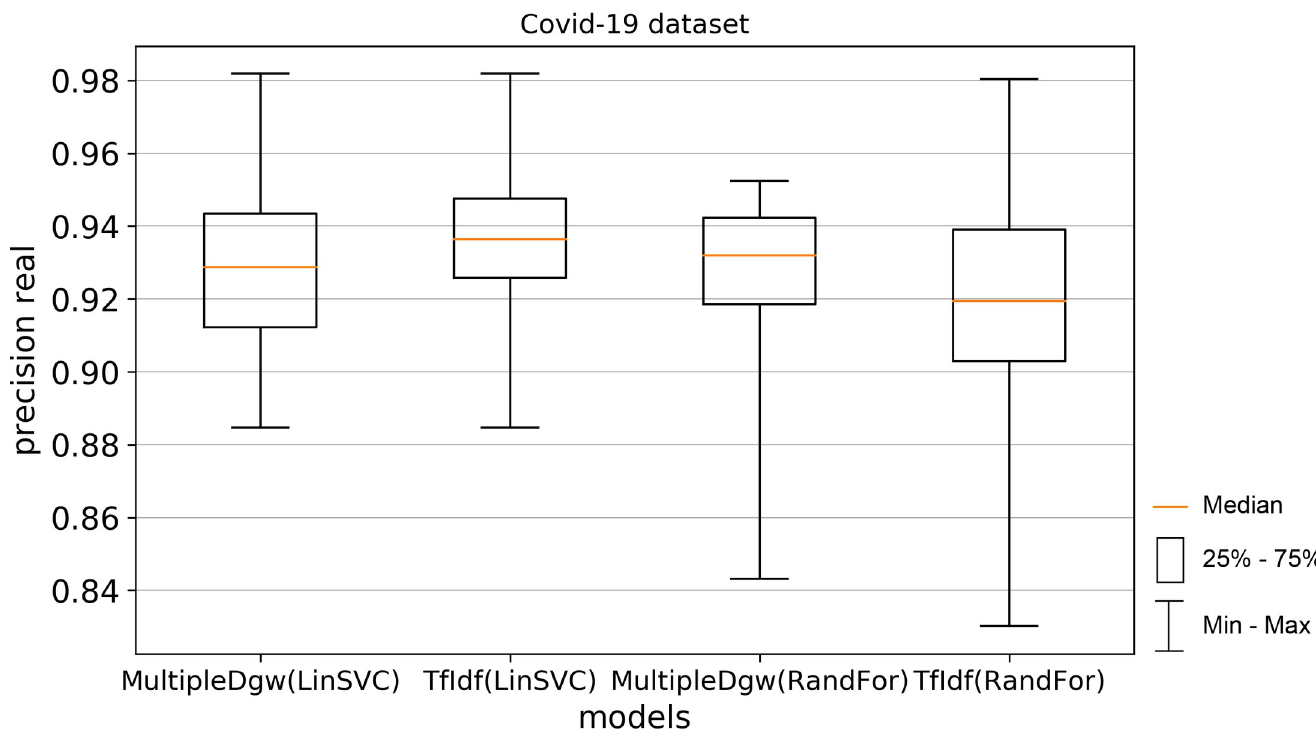
Fig 8. Boxplot for the model performance measurement—precision_real for dataset Covid-19.